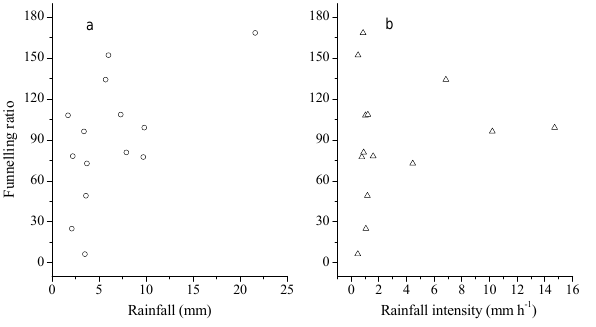
Fig. 5. Relationship between funnelling ratio and rainfall amount (a) and rainfall intensity (b).